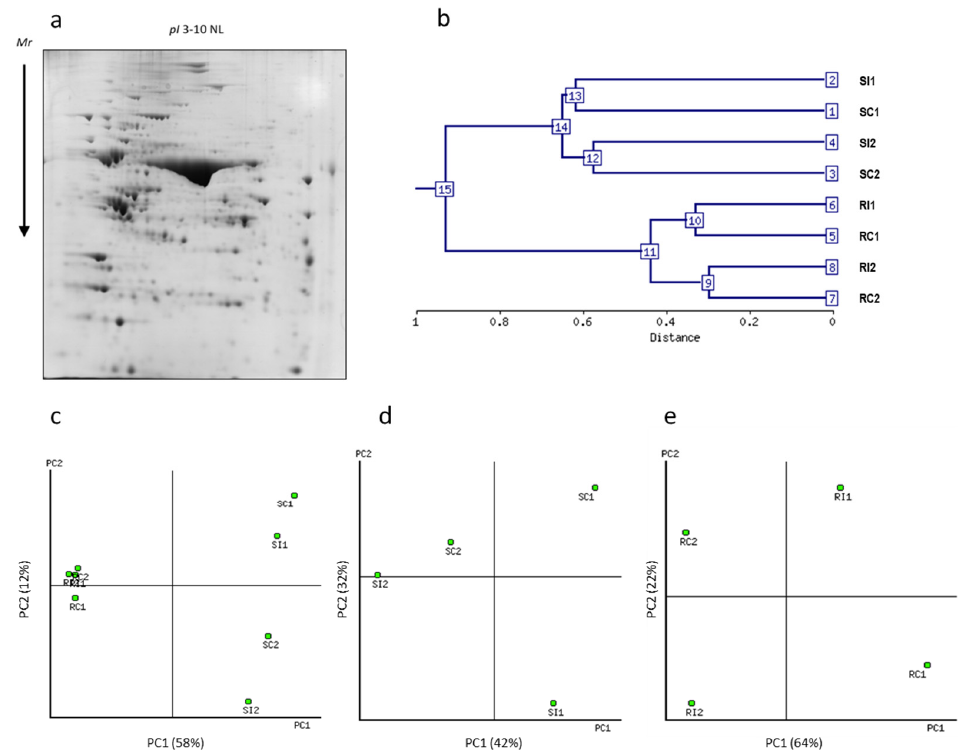
Figure 2. Typical Coomassie Brilliant Blue 2DE gel results for the susceptible genotype. ( a ) Den- drogram showing hierarchical clustering of experimental conditions. ( b ) Two-dimensional biplots showing associations between all experimental conditions in both genotypes ( c ), or independent genotypes ( d , e ), as generated by principal component analysis (PCA). Dendrogram and PCA data were obtained from average values under each set of experimental conditions: Susceptible (S) and resistant (R) genotypes; control (C) and B. fabae inoculated (I); 6 hpi (1) and 12 hpi (2).